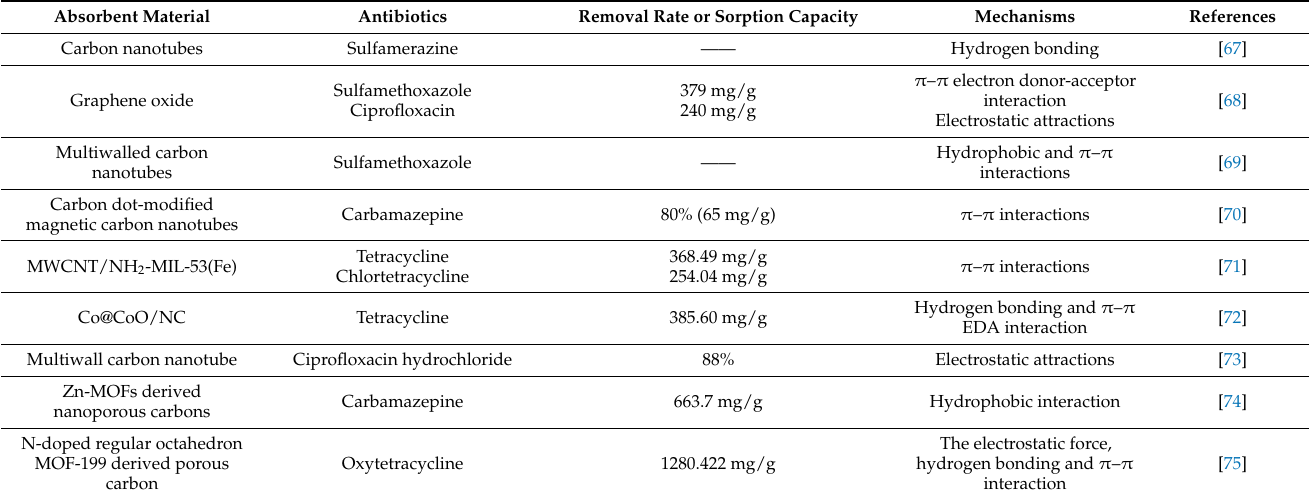
Table 2. The performance of antibiotics adsorption with different carbon-based